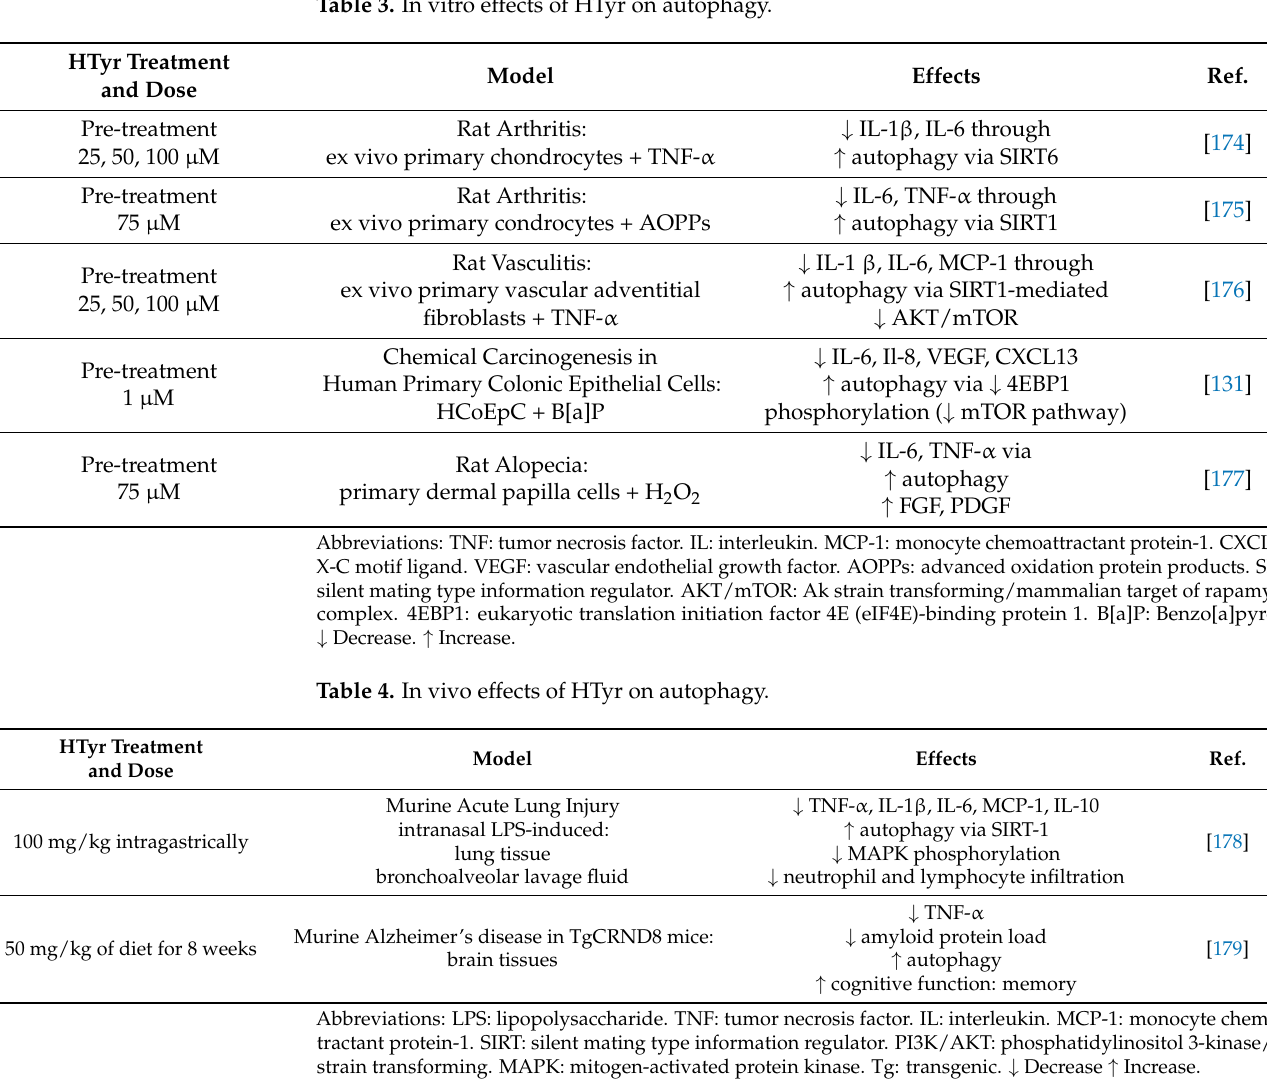
Table 3. In vitro effects of HTyr on autophagy.